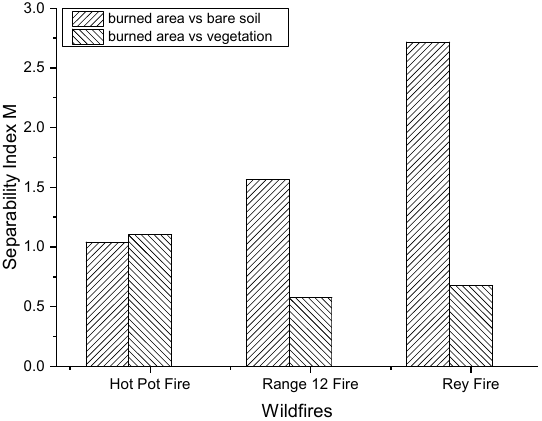
Figure 7. Separability index M of reflectance at band 5 for two comparisons (burned area vs. bare soil, burned area vs. vegetation) in the Hot Pot Fire, Range 12 Fire and Rey Fire.